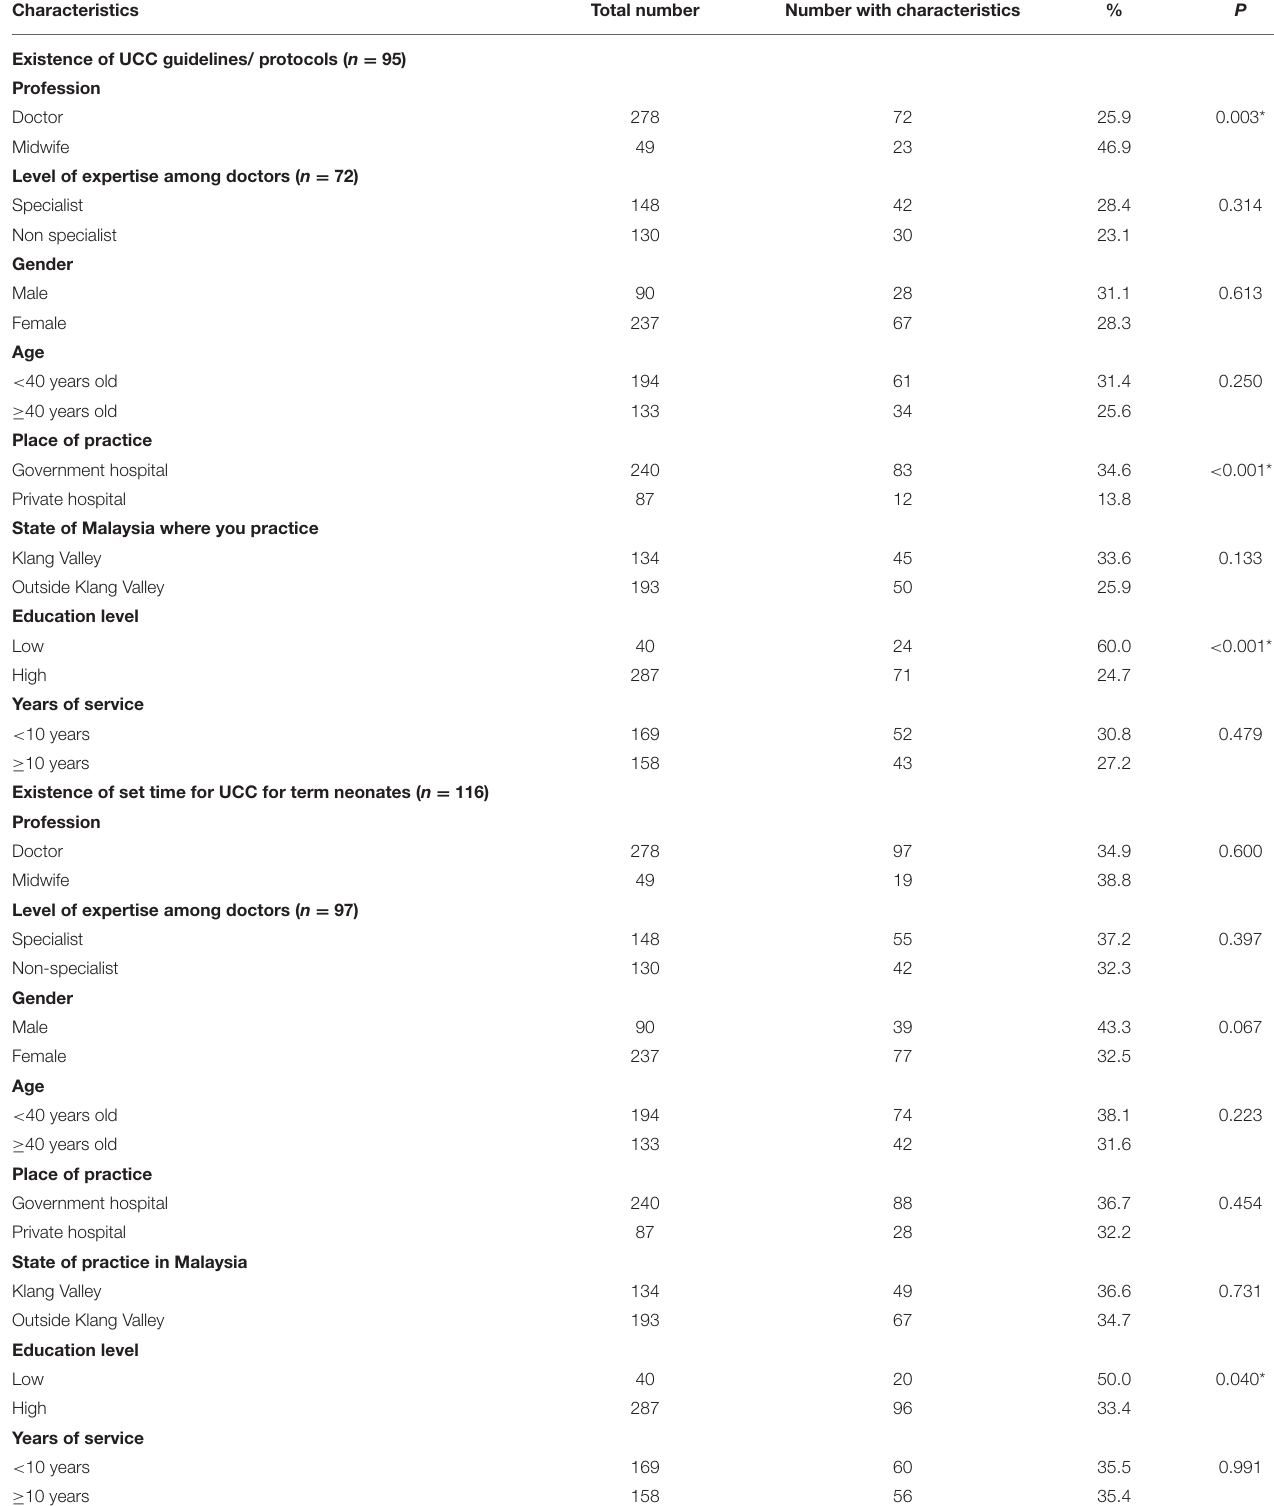
TABLE 3 | Existing UCC practices with demographic characteristic.